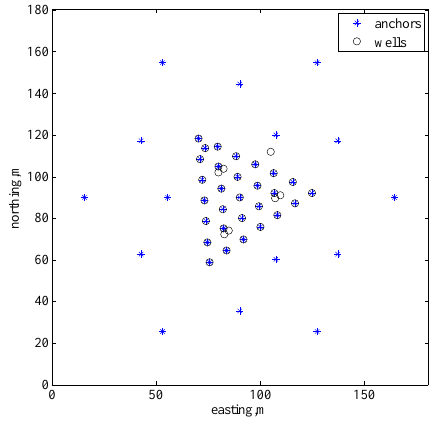
Fig. 3. Anchor locations in the domain for the constant-rate injec- tion test inversion. The reference point of local coordinates is at (594164m, 115976m) in the Hanford